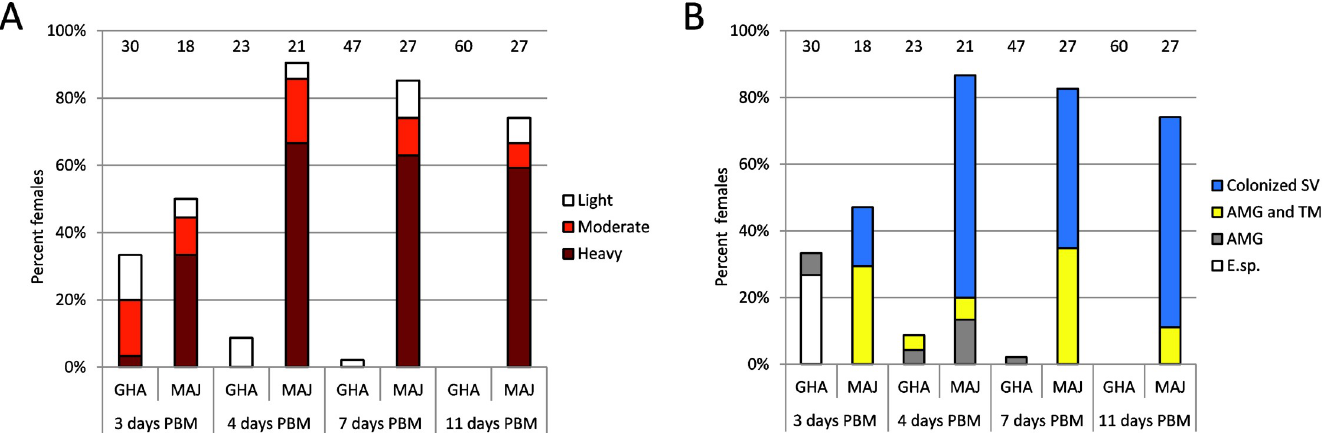
Fig 3. Mundinia development in the sand fly Phlebotomus duboscqi . Intensity (A) and localization (B) of L . sp. strain GH5 from Ghana (GHA) and L . major (MAJ) infections. SV, stomodeal valve; AMG, abdominal midgut; TMG, thoracic midgut; E. sp., endoperitrophic space; PBM, post blood meal. Intensity of infection (parasite load) was categorized as light, < 100 parasites per gut; moderate, 100–1000 parasites per gut and heavy, > 1000 parasites per gut. Numbers of dissected females are displayed above the columns. Differences among Leishmania species were significant and increased from day 3 PBM (P = 0.039, X 2 = 8.352, d.f. = 3) to day 4 PBM (P < 0.0001, X 2 = 34.008, d.f. = 3), 7 PBM (P < 0.0001, X 2 = 54.884, d.f. = 3) and day 11 PBM (P < 0.0001, X 2 = 57.711, d.f. =